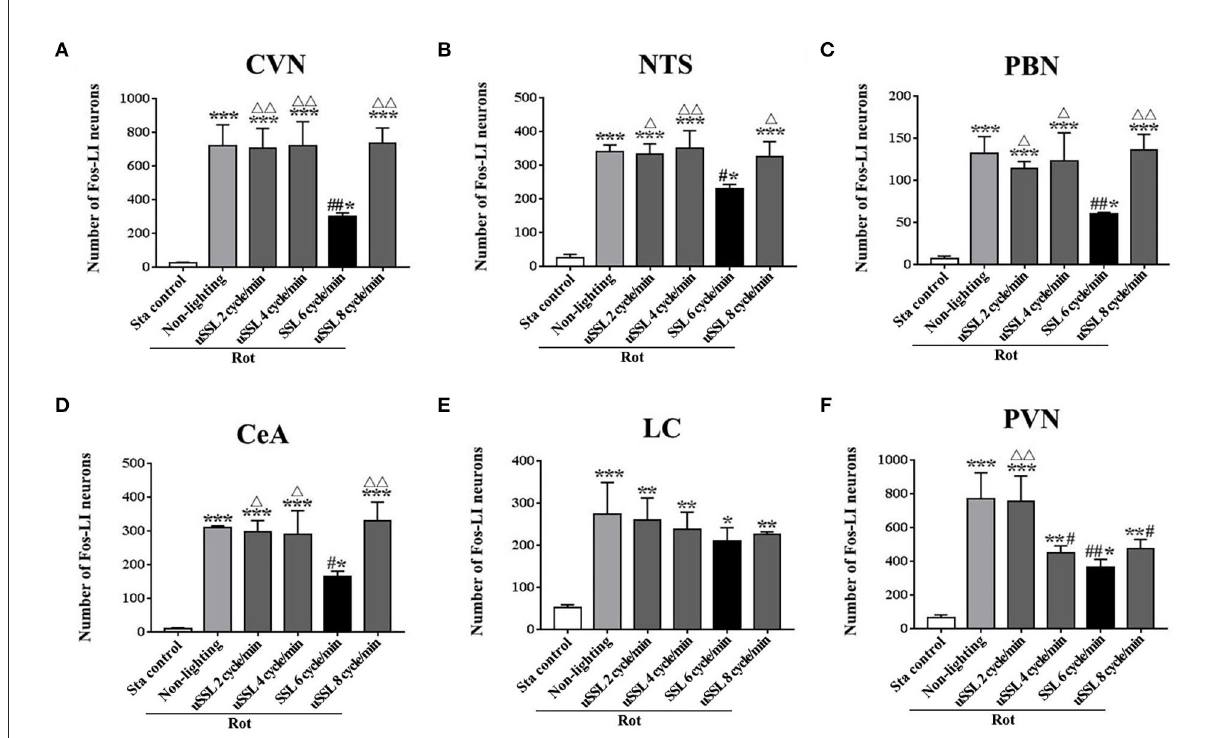
FIGURE6 Number of Fos-labeled neurons in the vestibulo-autonomic and stress-related areas in rats receiving synchronized or unsynchronized stroboscopic lighting at 100Lm during rotation. Fos-labeled neurons were quantified in the caudal vestibular nucleus [CVN, (A) ], the nucleus of solitary tract [NTS, (B) ], the parabrachial nucleus [PBN, (C) ], the central amygdala [CeA, (D) ], the locus ceruleus [LC, (E) ], and the paraventricular hypothalamus nucleus [PVN, (F) ]. Rot, rotation stimulation; Sta, static control treatment; SSL, synchronized stroboscopic light; uSSL, unsynchronized stroboscopic light; data are expressed as mean ± S.E. * P < 0.01, ** P < 0.01, *** P < 0.001 vs. the Sta control group; # P < 0.05, ## P < 0.01 vs. the Rot non-lighting group. 1 P < 0.05, 11 P < 0.01 vs. the 6 cycle/min Rot